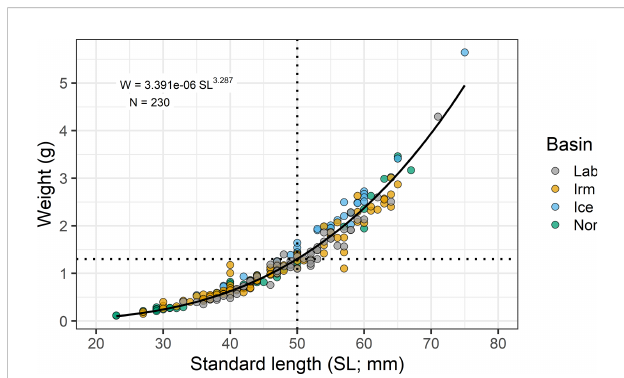
FIGURE 3 Weight-length relationship for B glaciale . Data from all fi sh processed for stomach content, liver and gonads (N = 230) from all basins are